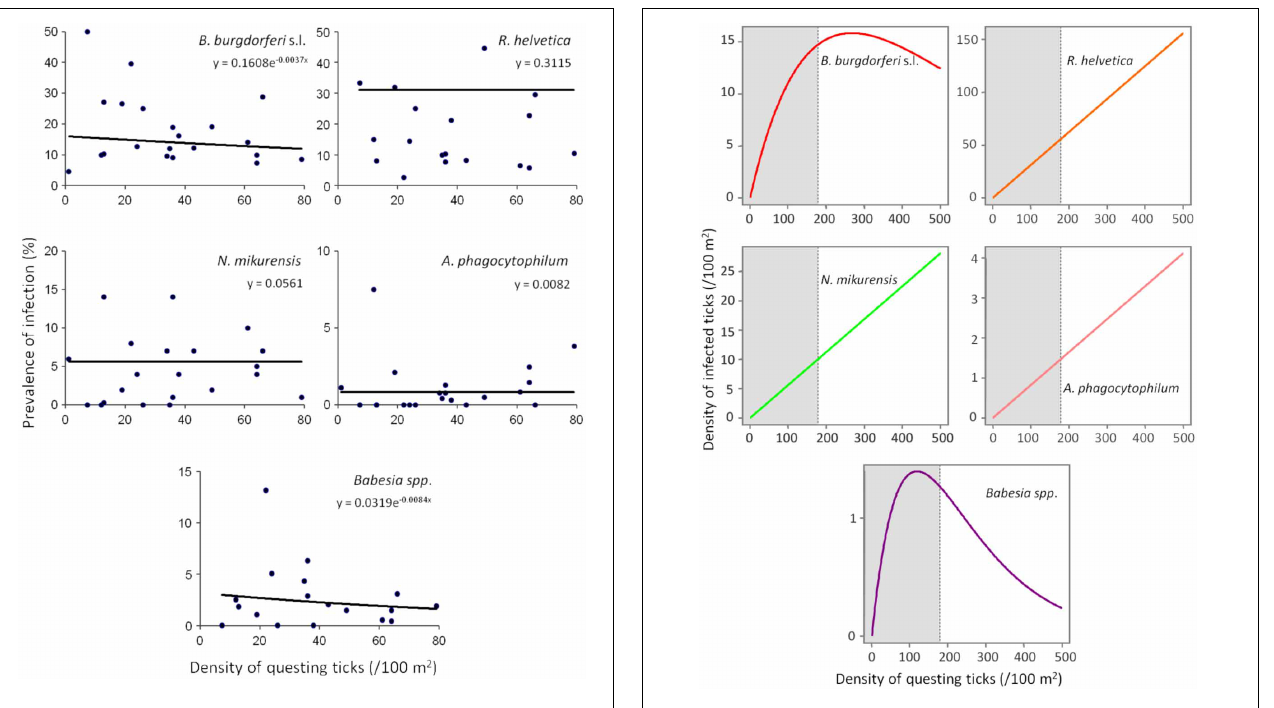
FIGURE 4 | Evolution of the density of infected ticks (y-axis) with the density of questing ticks (x-axis). The density of infected ticks is obtained by fitting a model ( p = aExp [ bd ] ) to a range of questing ticks densities. The numbers are expressed as ticks/100m 2 . The gray area marks the normal questing ticks densities (0–179/100m 2 ) in The